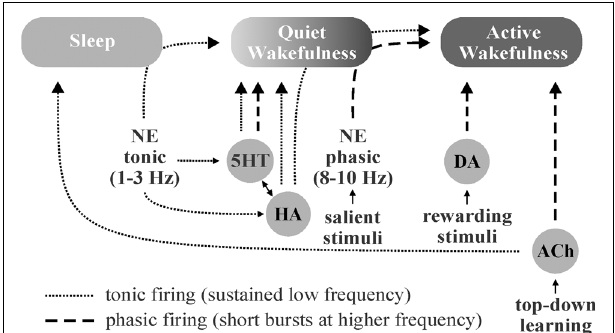
FIGURE 3 | Schematic illustration of putative neuromodulator roles in the regulation of sleep-wake states. Norepinephrine (NE)-, histamine (HA)-, and serotonin (5HT)-associated neurons are quiet-to-quiescent during sleep and tonically active during wakefulness. NE appears to be chiefly involved in rousing from sleep and/or promoting attention (active wakefulness) in response to important stimuli, HA in sustaining general vigilance, and 5HT in maintaining quiet (non-attentive) wakefulness. While acetylcholine (ACh) does promote wakefulness, it appears to primarily function in mediating the sustained attention observed during “top-down” learning. The role of dopamine (DA) in sleep-wake state regulation is less clear, though DA neurons are known to engage in burst firing in response to rewarding and/or aversive stimuli, which promotes